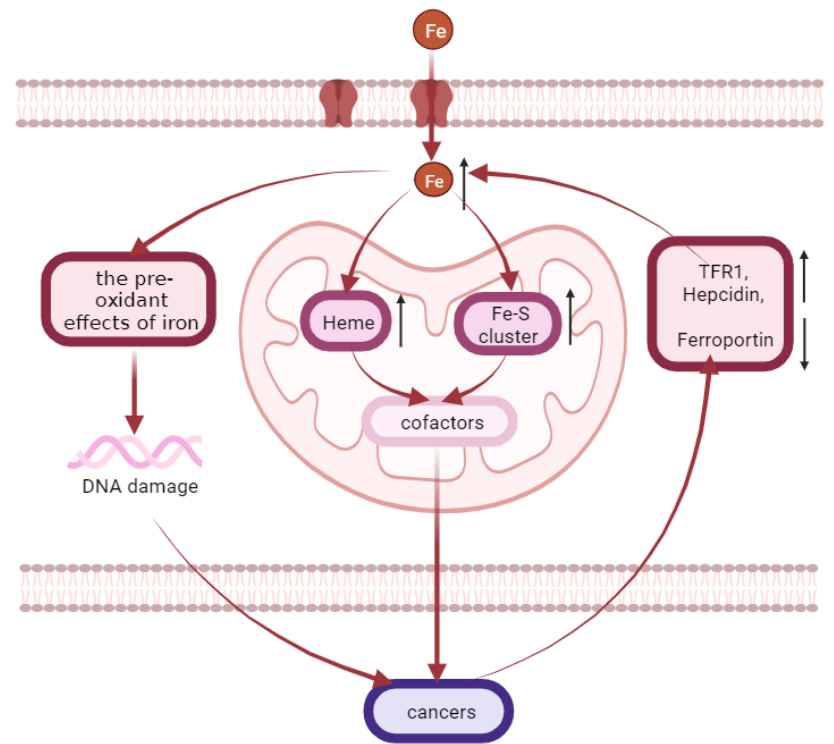
Figure 4. Iron accumulation is related to the occurrence of various cancers. Iron overload is related to the occurrence of various cancers such as liver, colon, rectum, lung, esophagus, and bladder cancers. There are two well-defined mechanisms of cancer development induced by iron excess. One is associated with the pre-oxidant effects of iron, which can lead to DNA damage and subsequently promote oncogenesis. The other one is that more iron may be imported to mitochondria of cancer cells during rapid cell proliferation, in order to produce heme and Fe-S cluster and to satisfy increasing demands for these cofactors. Meanwhile, the expression of iron homeostasis proteins associated with iron accumulation is altered in multiple cancer cell types, such as an elevated expression of the iron uptake-related protein TFR1, a reduced expression of the iron export-related protein ferroportin, and an elevated production of hepcidin.